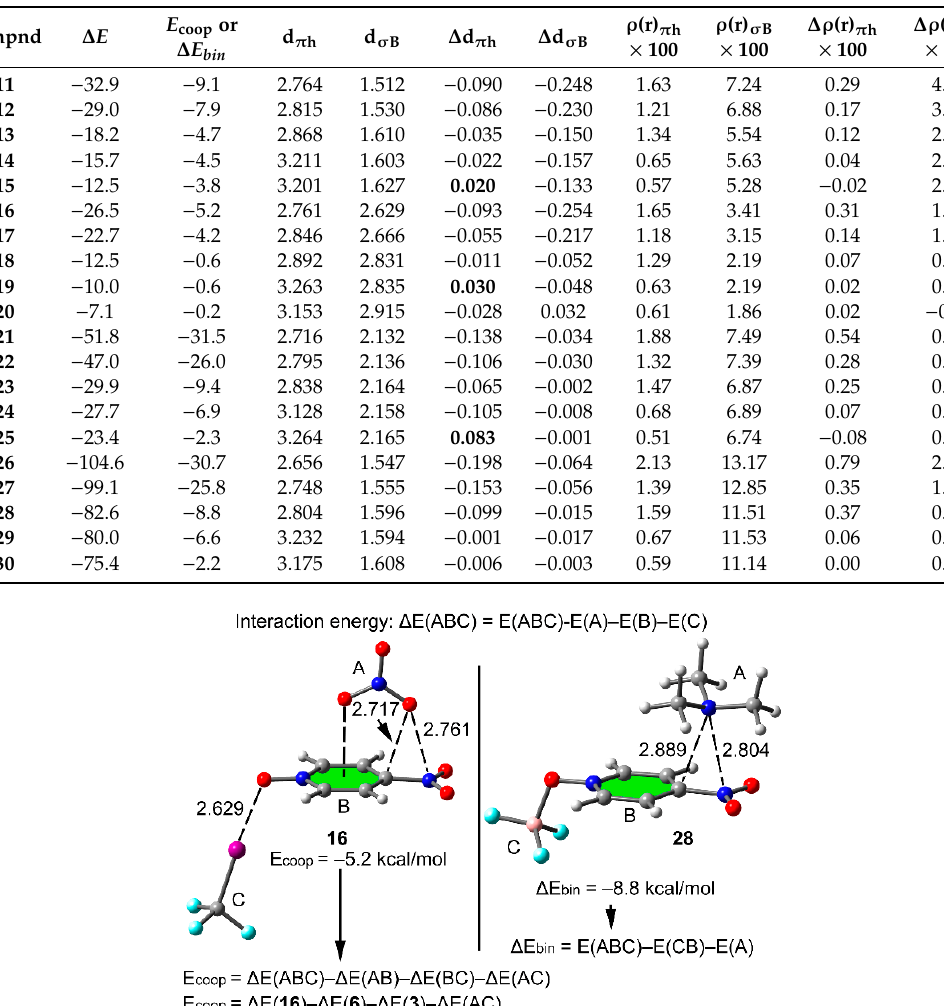
Table 3. Interaction, binary, and cooperativity energies ( ∆ E , ∆ E bin, and E coop , respectively, in kcal mol − 1 ) for complexes 11 – 30 at the PBE0-D3 / def2-TZVP level of theory. Equilibrium distances in Å denoted as d π h for π –hole and d σ B for the HB / XB / CB / TrB interaction. The increment or decrement (in bold) of the equilibrium distances denoted as ∆ d π h and ∆ d σ are also included. The values of the charge density 100 × ρ (r) at the bond CP and its variation 100 × ∆ ρ (r) for complexes 11 – 30 are given in a.u.